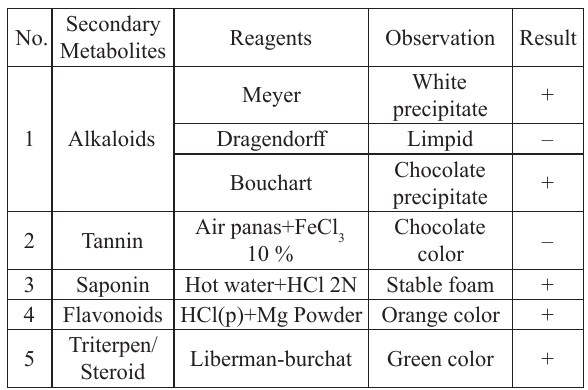
Phytochemical Screening Results of Yellow Potato